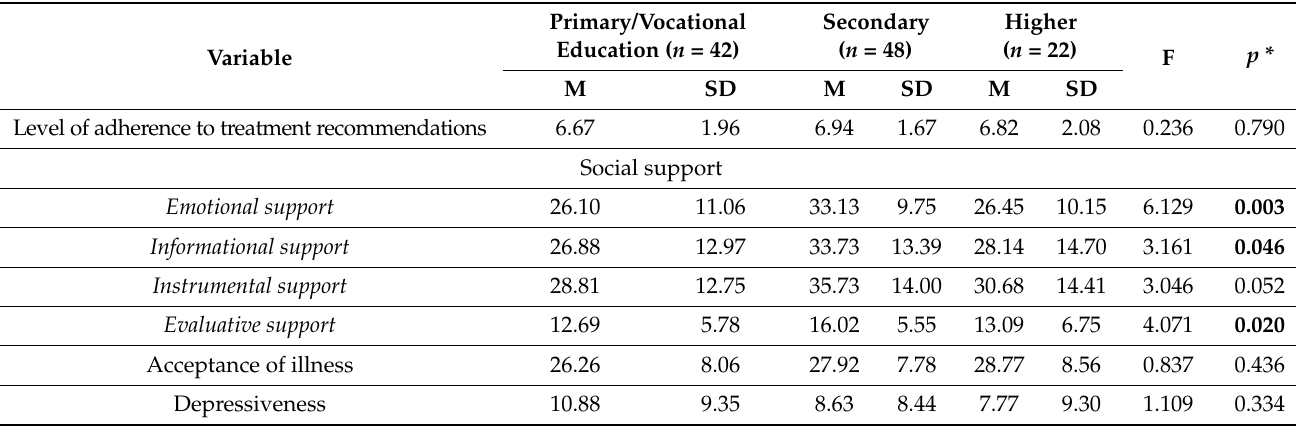
Table 5. Adherence to treatment recommendations, social support according to the ISSB, acceptance of disease according to the AIS, and depression according to the BDI among liver transplant patients by